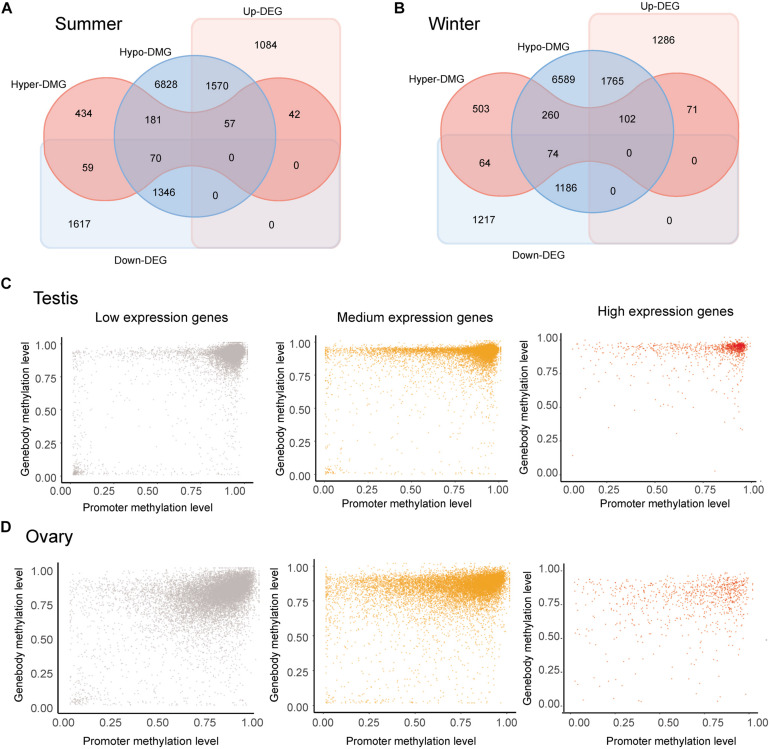
Correlation analysis of the methylome and transcriptome. (A,B) Venn diagram of sex-biased differentially methylated genes (DMGs) and differentially expressed genes (DEGs) in gonads collected in the summer (A) and winter (B). (C,D) Methylation levels in the promoter and gene body of genes showing low (FPKM < 1), medium (1 < FPKM < 100), and high (FPKM > 100) expression in the ovary (C) and testis (D) collected in summer.